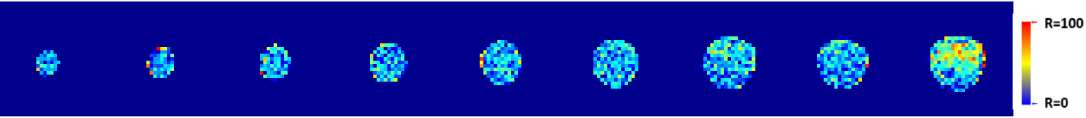
Figure 2. An illustration of the color map generated by the MRI analysis